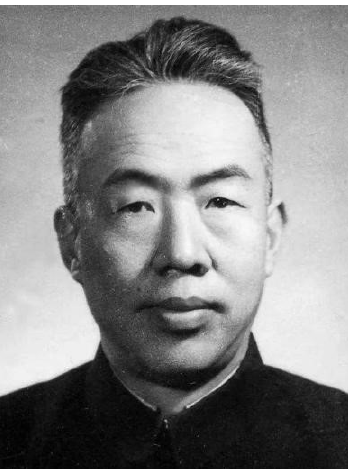
Figure 1. Jeou-jang Jaw (15 October 1907–26 October 1968). Source: courtesy of the Chinese Academy of Sciences.